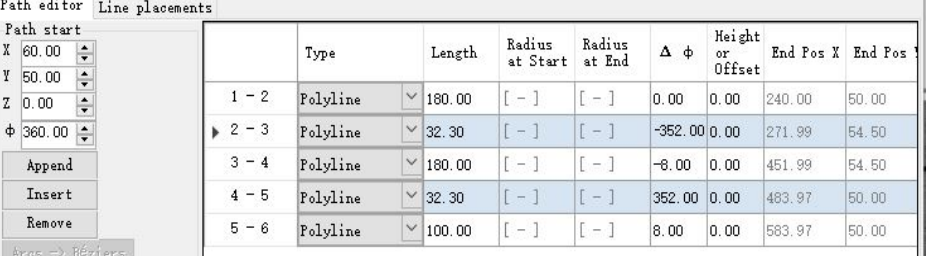
Figure 16. Vehicle track information.